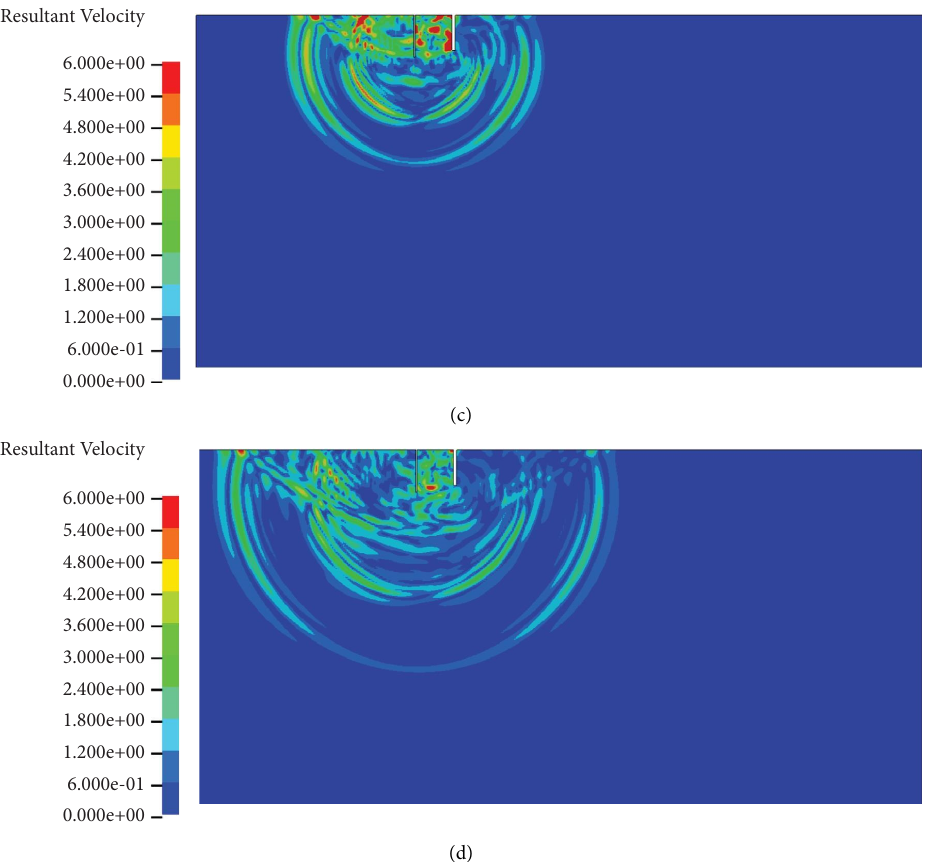
Figure 4: Propagation characteristics of vibration resultant velocity with a vibration-isolating slot. (a) Time � 1ms. (b) Time � 3 ms. (c) Time � 5ms. (d) Time �